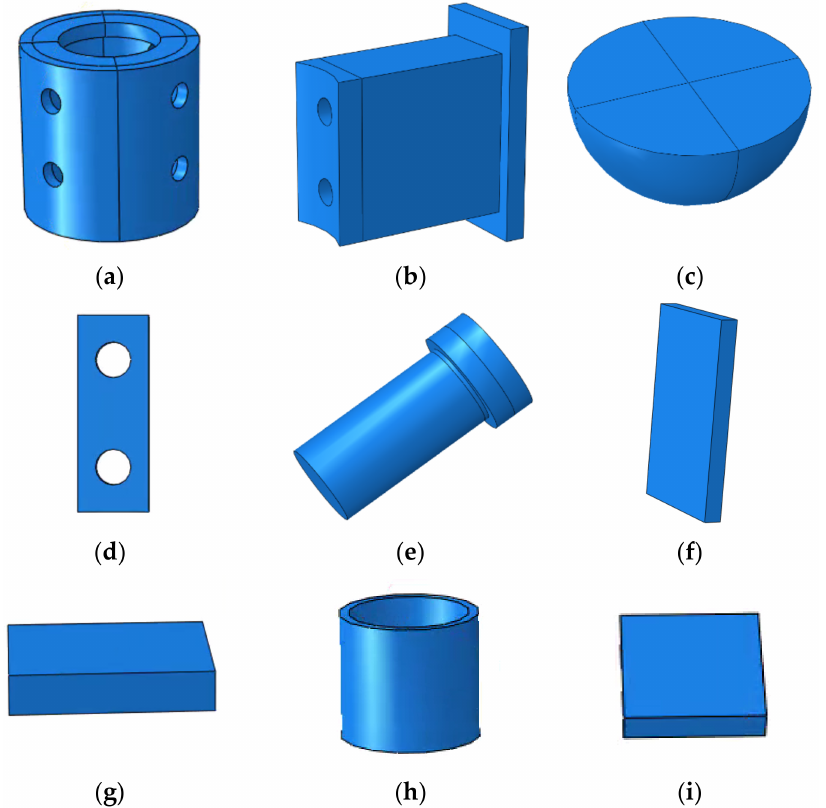
Figure 2. Schematic diagram of each part of BBC joint: ( a ) circular tube; ( b ) tubular beam with end plate; ( c ) solid hemisphere; ( d ) convex washer; ( e ) bolt; ( f ) loading plate; ( g ) supporting plate; ( h ) loading tube; ( i ) loading plate on